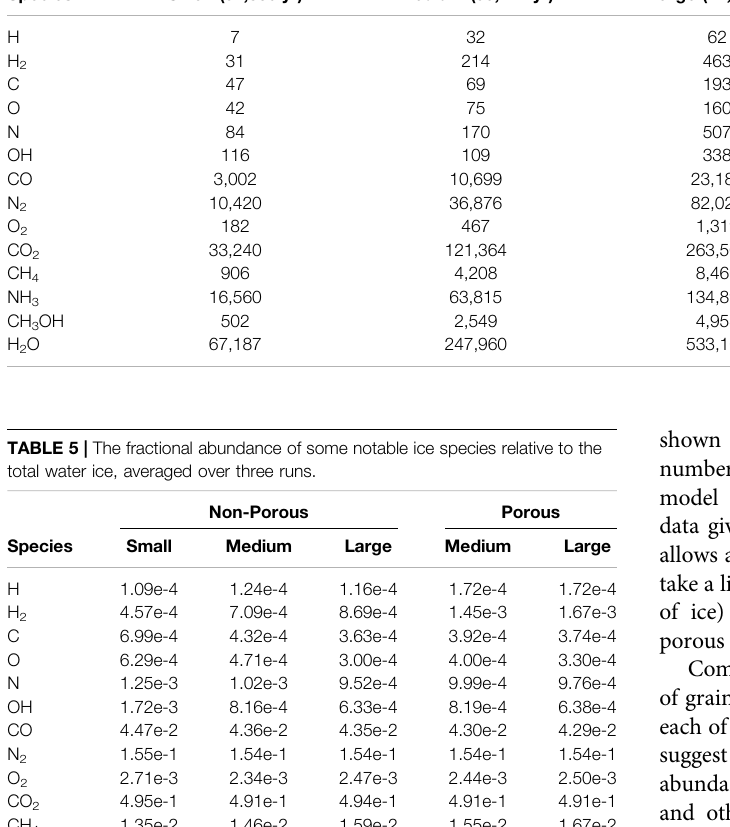
TABLE 4 | The total abundance of some notable ice species averaged over three runs. The fi nal time of each model is also indicated, which corresponds to interval 1,000 in each case. Non-Porous Porous